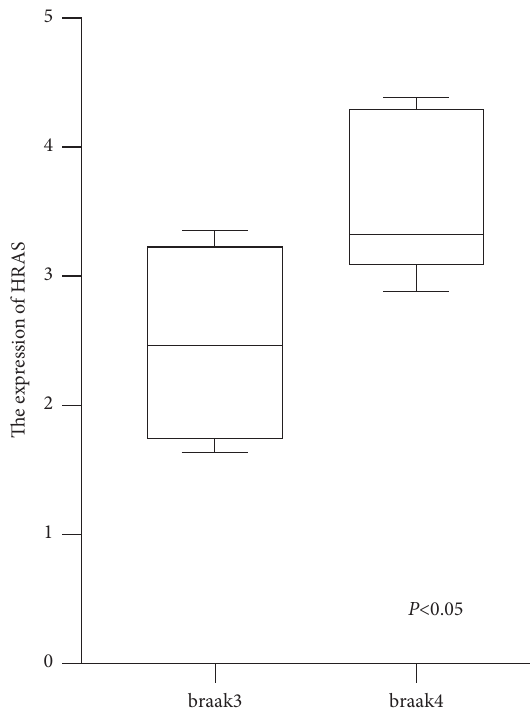
Figure 7: The expression of HRAS in brain tissues of patients with Braak 3 and Braak